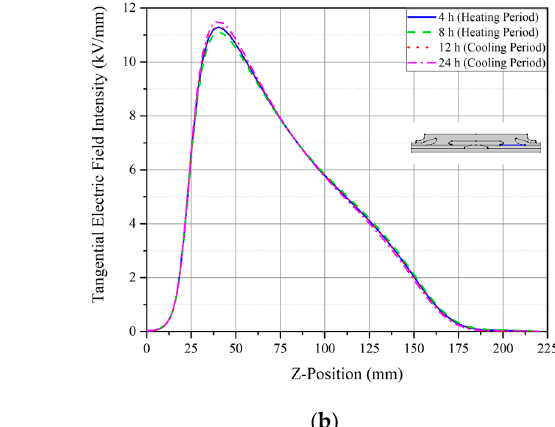
( b ) Figure 10. Mechanical stress distribution during load cycle: ( a ) Radial stress; ( b ) Hoop stress.